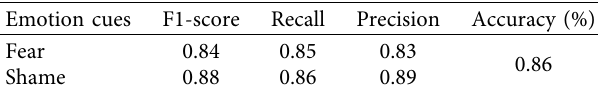
Table 4: Proposed BILSTM model performance evaluation results. Table 5: Proposed BILSTM model performance evaluation